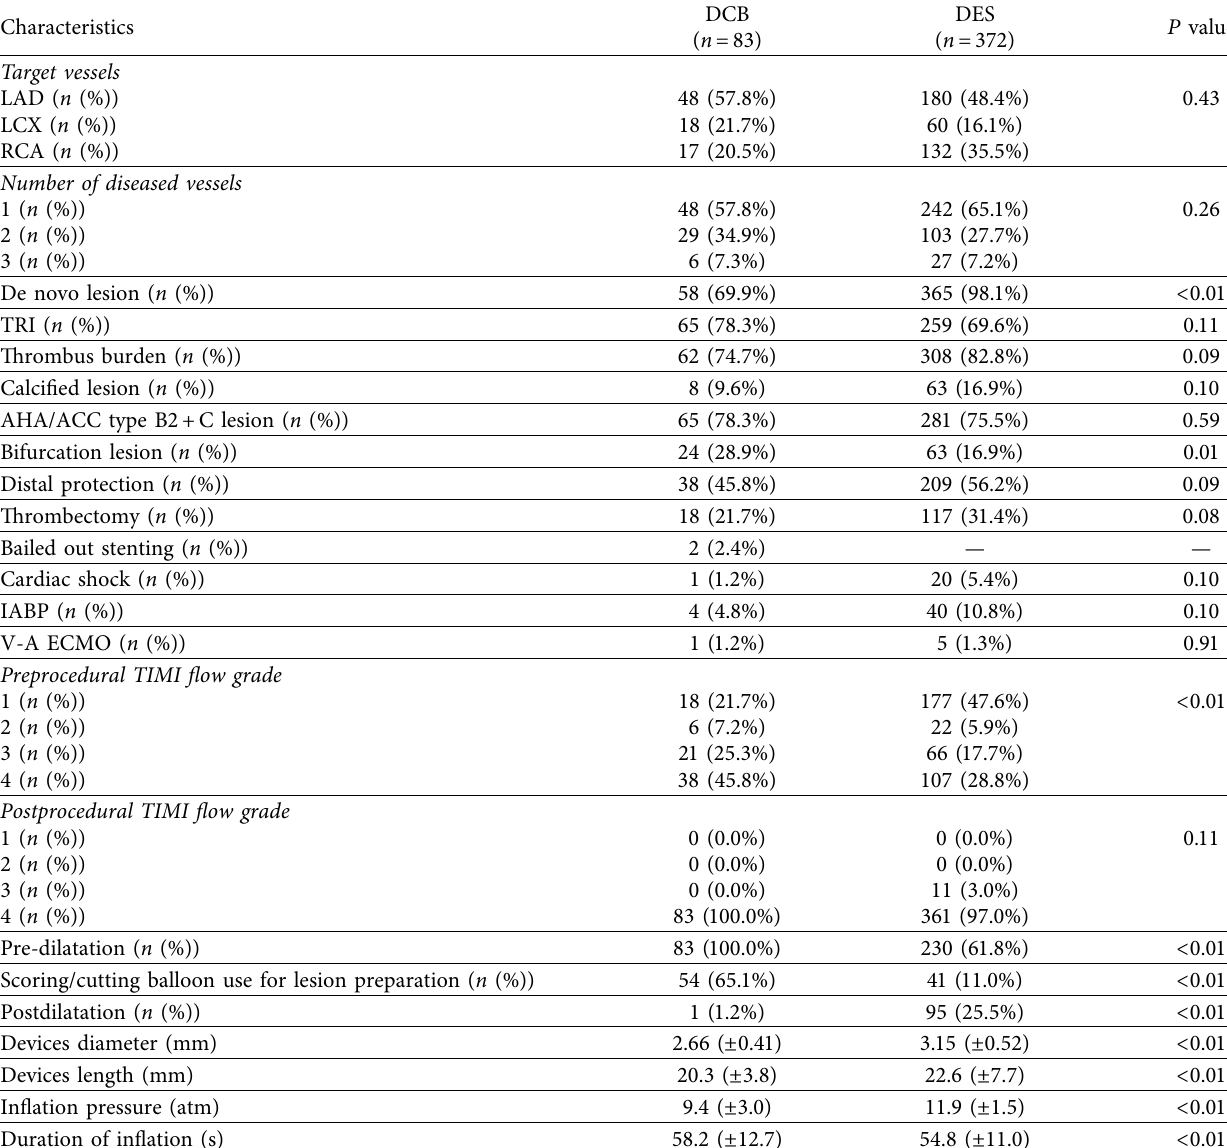
Table 2: Lesion and procedural